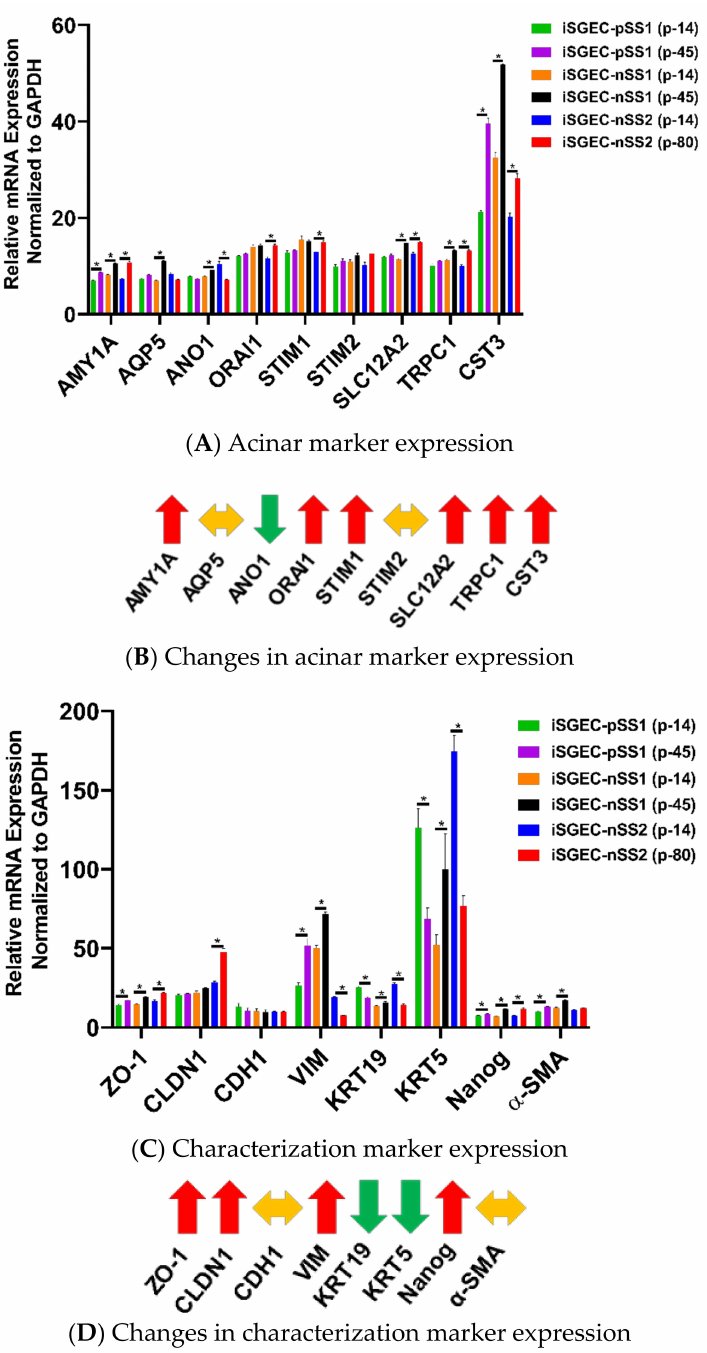
Figure 4. Changes in mRNA expression of early and late passaged iSGECs by qRT-PCR. Legend. mRNA expression of acinar ( A ) and characterization markers ( C ) in monolayer cultures of early and late passaged iSGECs by qRT-PCR ( ∆ CT). iSGECs increased in AMY1A ( A ), ZO-1 ( C ), and Nanog ( C ) in later passages. Changes in gene expression of iSGEC-nSS2 early (p-14) and late (p-80) are indicated with arrows: increased ( red ), decreased ( green ), and no change ( yellow ). ( B,D ) iSGEC-nSS2 di ff erentially expressed several acinar and characterization markers in later passages. Significance of di ff erences between the means was determined by Student’s t -test and p -values corrected using the Holm–Šid á k multiple comparisons post hoc test (alpha = 0.05). Error bars represent mean +/ − SEM. * p < 0.05. Characterization markers were the most di ff erentially expressed and exhibited the greatest changes in late passaged iSGECs. Epithelial marker CDH1 was the only stably expressed gene among